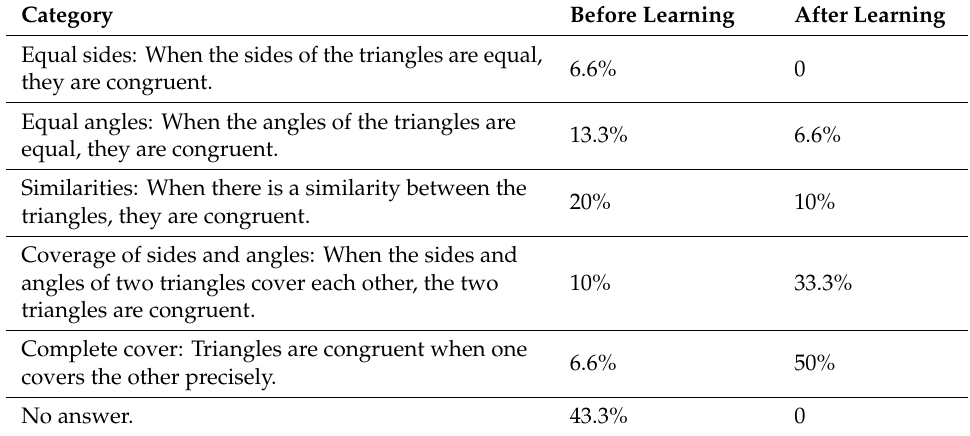
Table 1. Students’ definitions of the congruent triangles, before and after the learning process.